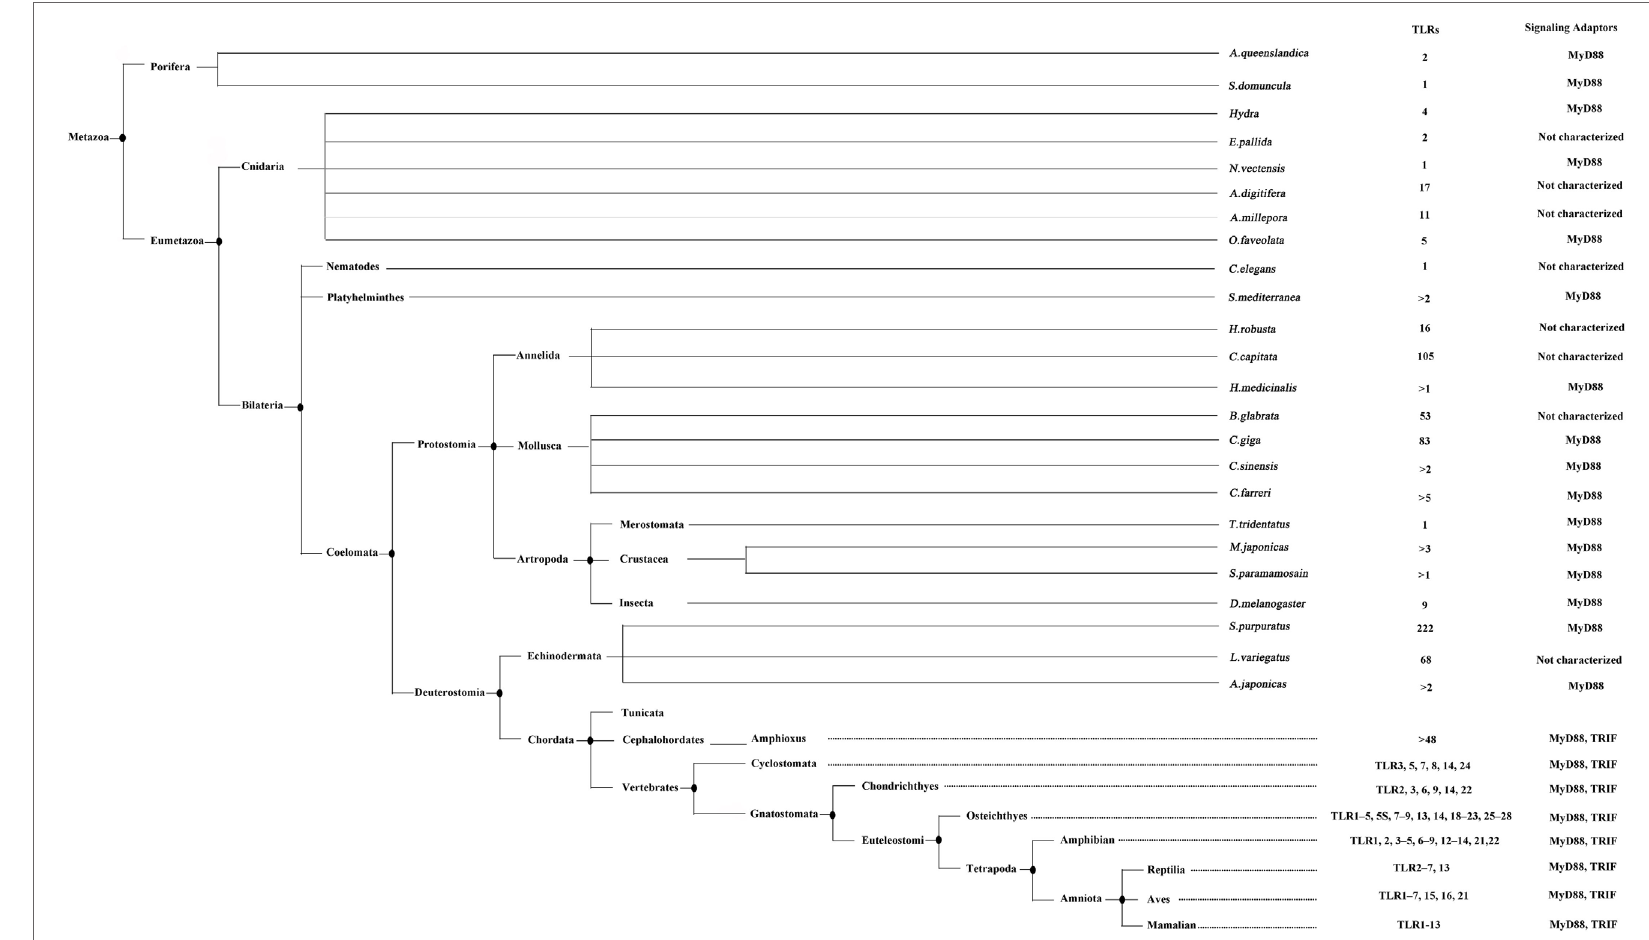
FiGURe 1 | The evolution analysis of toll-like receptors (TLRs) in reported taxa and species. This tree is generated according to the lineages reported by NCBI taxonomy database (http://www.ncbi.nlm.nih.gov/ taxonomy). The TLRs identified in different species and the signaling adaptors involved are indicated. This figure is adapted from the publication of MR Coscia et al.